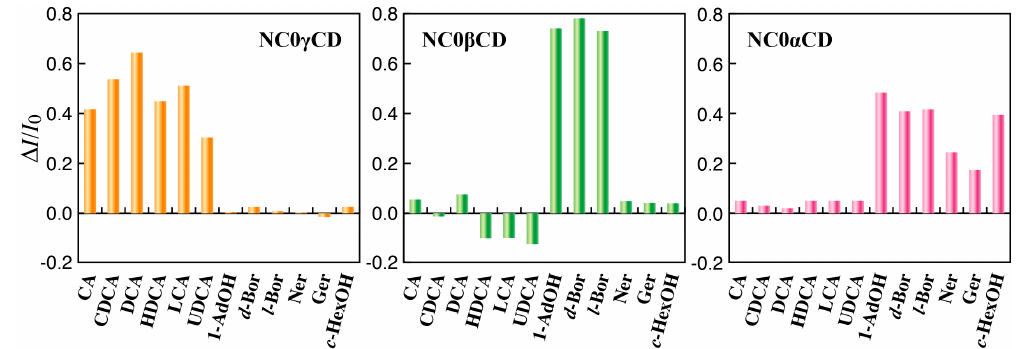
Figure 3. Sensitivity parameters ( Δ I / I 0 ) of NC0 α CD , NC0 β CD , and NC0 γ CD for various guests in phosphate bu ff er (200 mM, pH 7.0) at 25 ◦ C: [ NC0 α CD ] = [ NC0 β CD ] = [ NC0 γ CD ] = 5 × 10 − 6